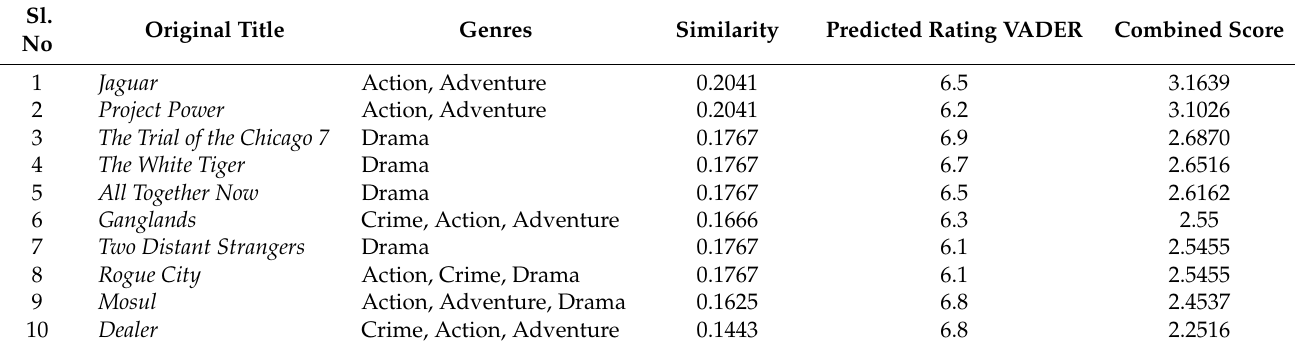
Table 15. Recommended movies for user u 6 .